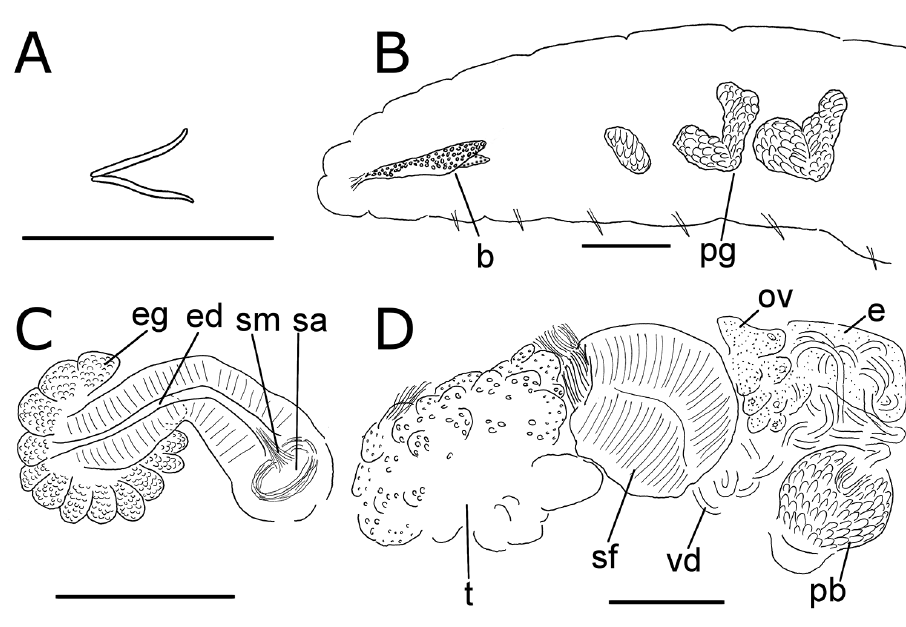
Figure 20. Lumbricillus knoellneri . A Chaetal bundle B Anterior body C Spermatheca D Other genitalia. Abbreviations under general notes. Scale bars: 100